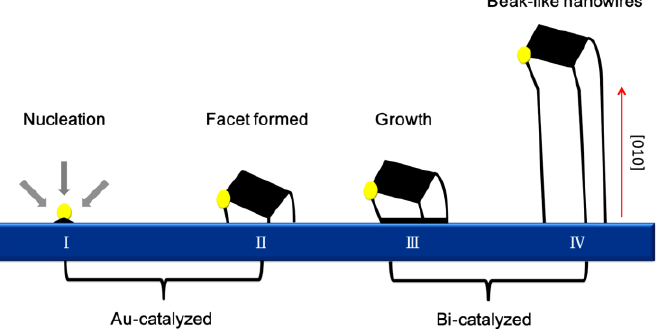
Figure 4. Sketch of growth mechanisms of α -Bi 2 O 3 nanowires. Processes I–II are driven by the Au-catalyzed mechanism for the formation of the (010) facet; processes III–IV are driven by the Bi-cata- lyzed mechanism for the formation of beaklike nanowires. Reproduced with permission from [78]. Copyright 2014 Elsevier.